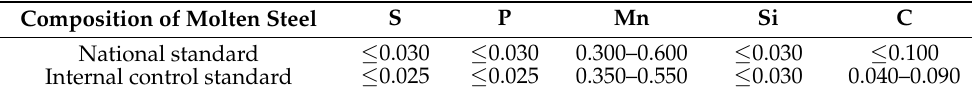
Table 1. Chemical composition of welding rod steels (wt%). Composition of Molten